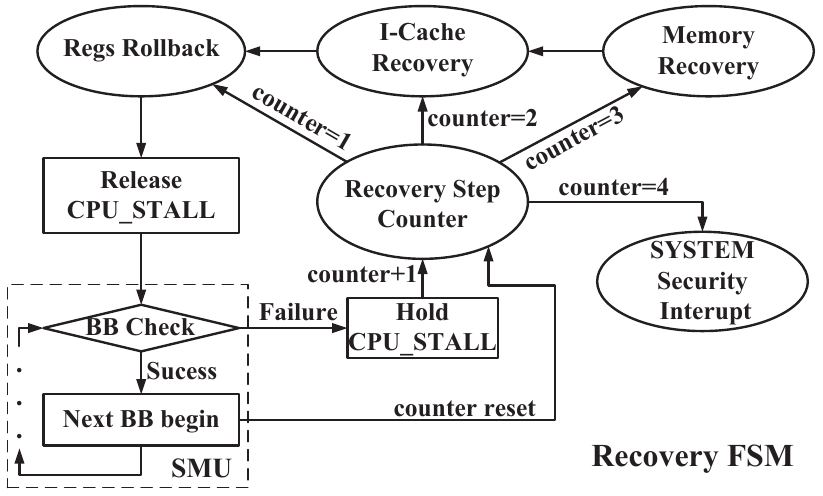
Figure 10. The FSM of recovery for FRU.